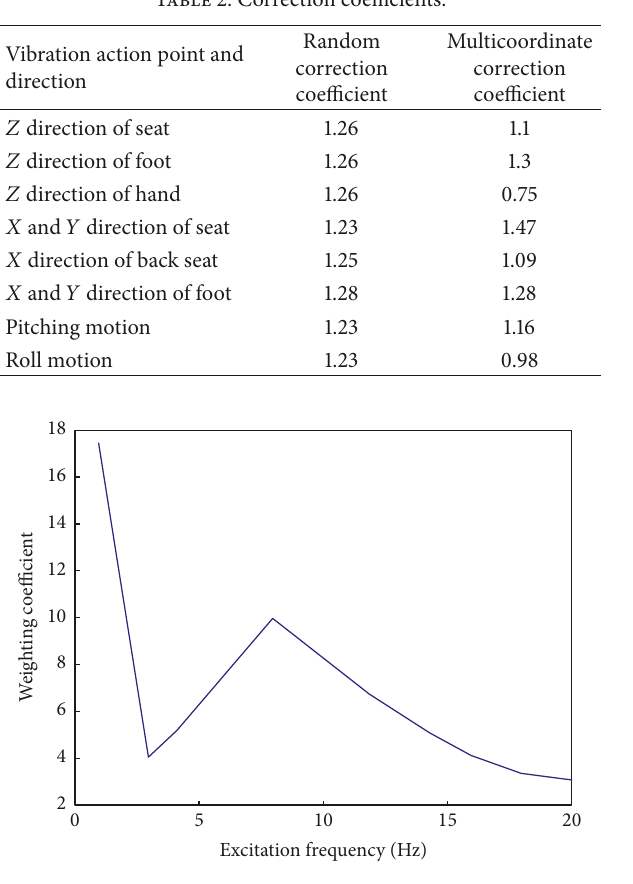
Figure 10: Evaluation value of the vibration.